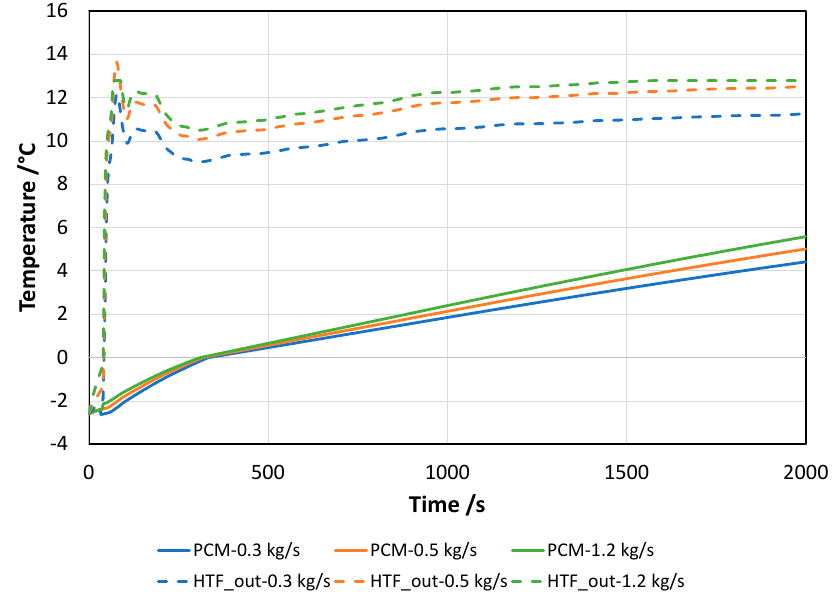
Figure 7. Average PCM temperature for different HTF flow rates during discharge for four layers and an HTF inlet at 12 °C.